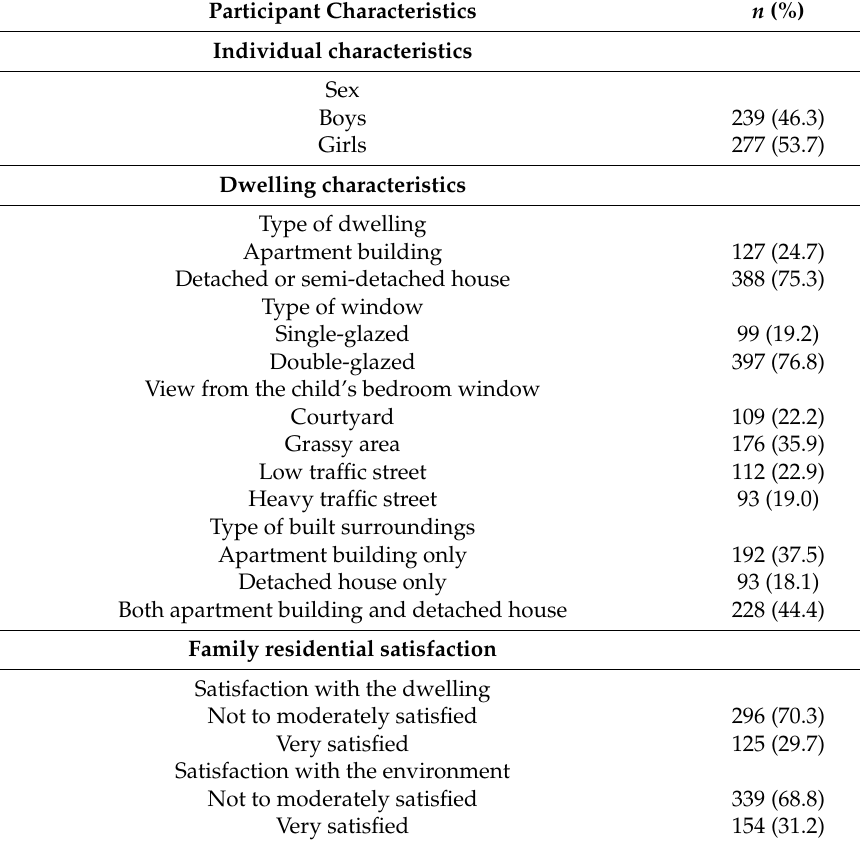
Table 1. Participant characteristics defined at the child and census block levels ( n =